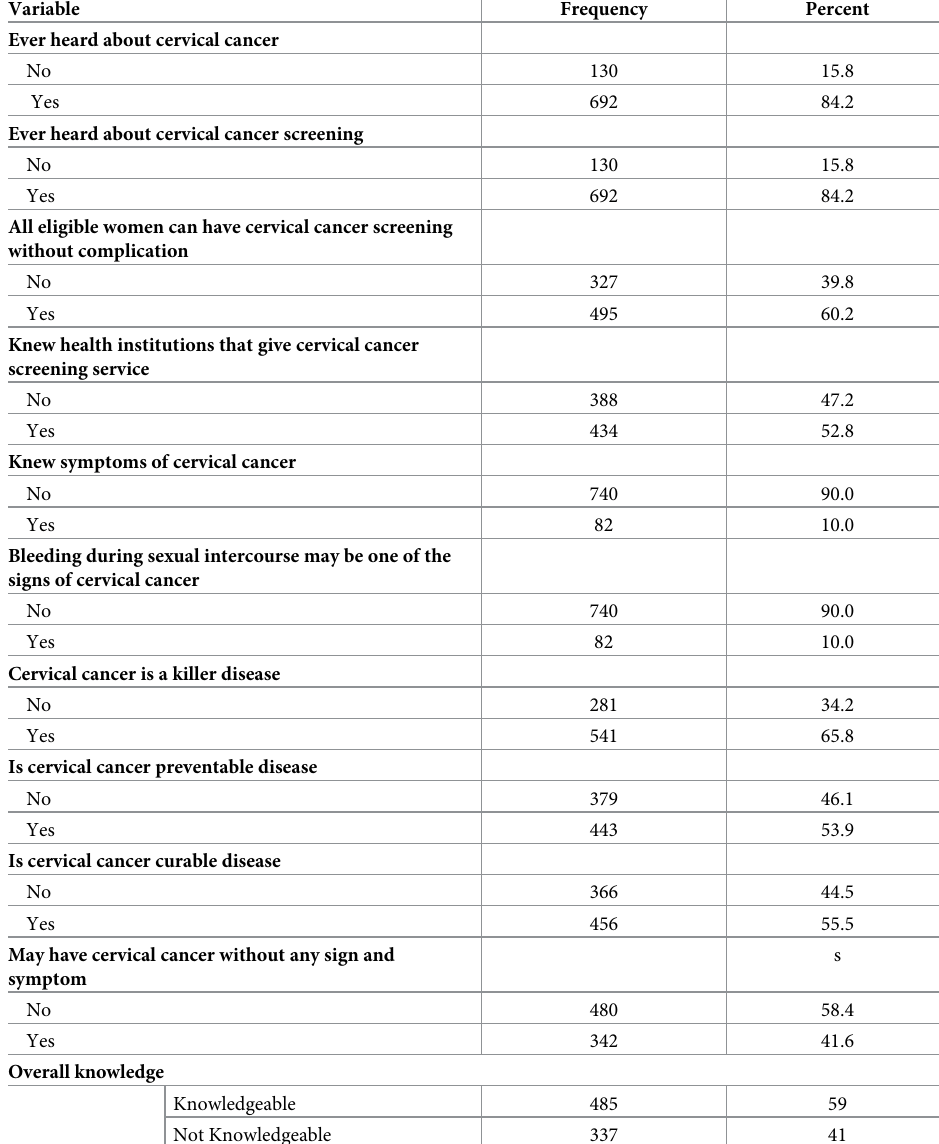
Table 3. Knowledge about cervical cancer screening among women (n = 822) in Debremarkos town, Northwest Ethiopia, 2018. Variable Frequency Percent Ever heard about cervical cancer No Ever heard about cervical cancer